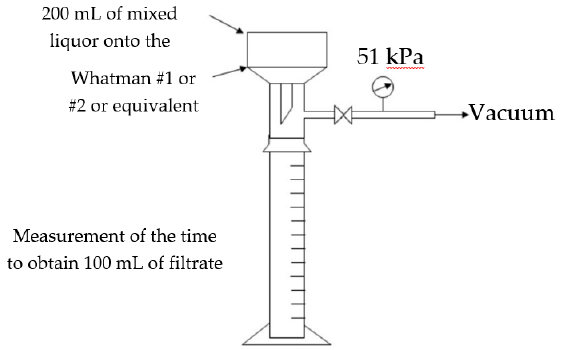
Figure 5. Schematic of the apparatus for measuring the TTF 100 [11].